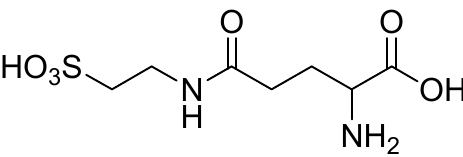
Figure 6. Structure of γ - L